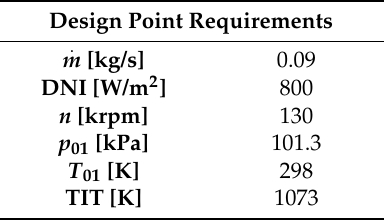
Table 2. Main design